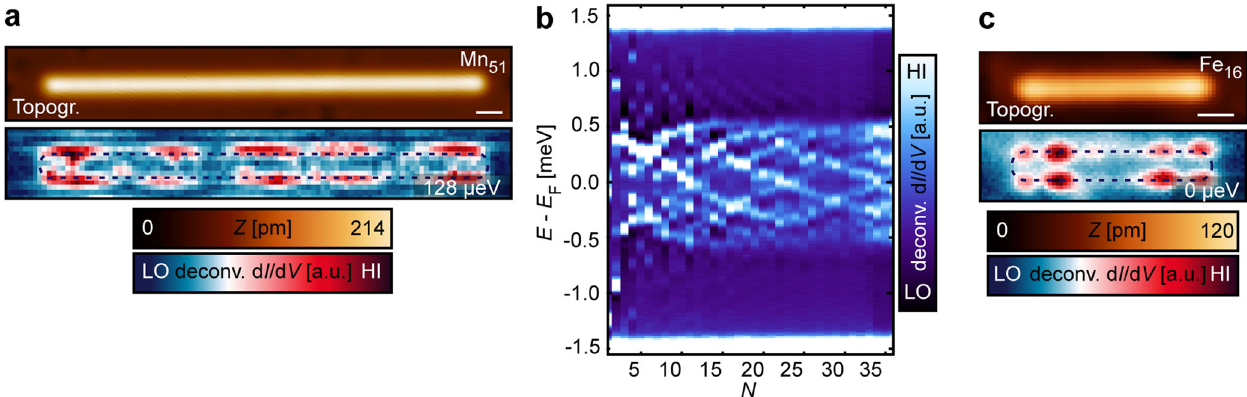
Fig. 4 Experimental observation of low-energy side features in linear atomic Mn and Fe chains on Nb(110). a Constant-current image (top panel) and deconvoluted d I /d V map (bottom panel) at E = 128 μ eV for a Mn 51 chain along the [001] direction. The white bar corresponds to 1 nm. The apparent extent of the chain from the upper panel is marked by the dark dashed lines in the d I /d V map. b Deconvoluted d I /d V spectra measured on the side of Mn N chains' one end while additional Mn atoms were attached to the chain on the other end, thereby mainly showing the evolution of the side features with chain length N ( c. f . refs. 20,31 ). c Constant-current image (top panel) and deconvoluted d I /d V map (bottom panel) at zero energy for a Fe 16 chain along the [001] direction, which is structurally identical to the Mn chain in panel ( a ). The white bar corresponds to 1 nm. The apparent extent of the chain from the upper panel is marked by the dark dashed lines in the d I /d V maps. Parameters: V stab = − 6 mV, I stab = 1 nA, V mod ¼ 20 μ